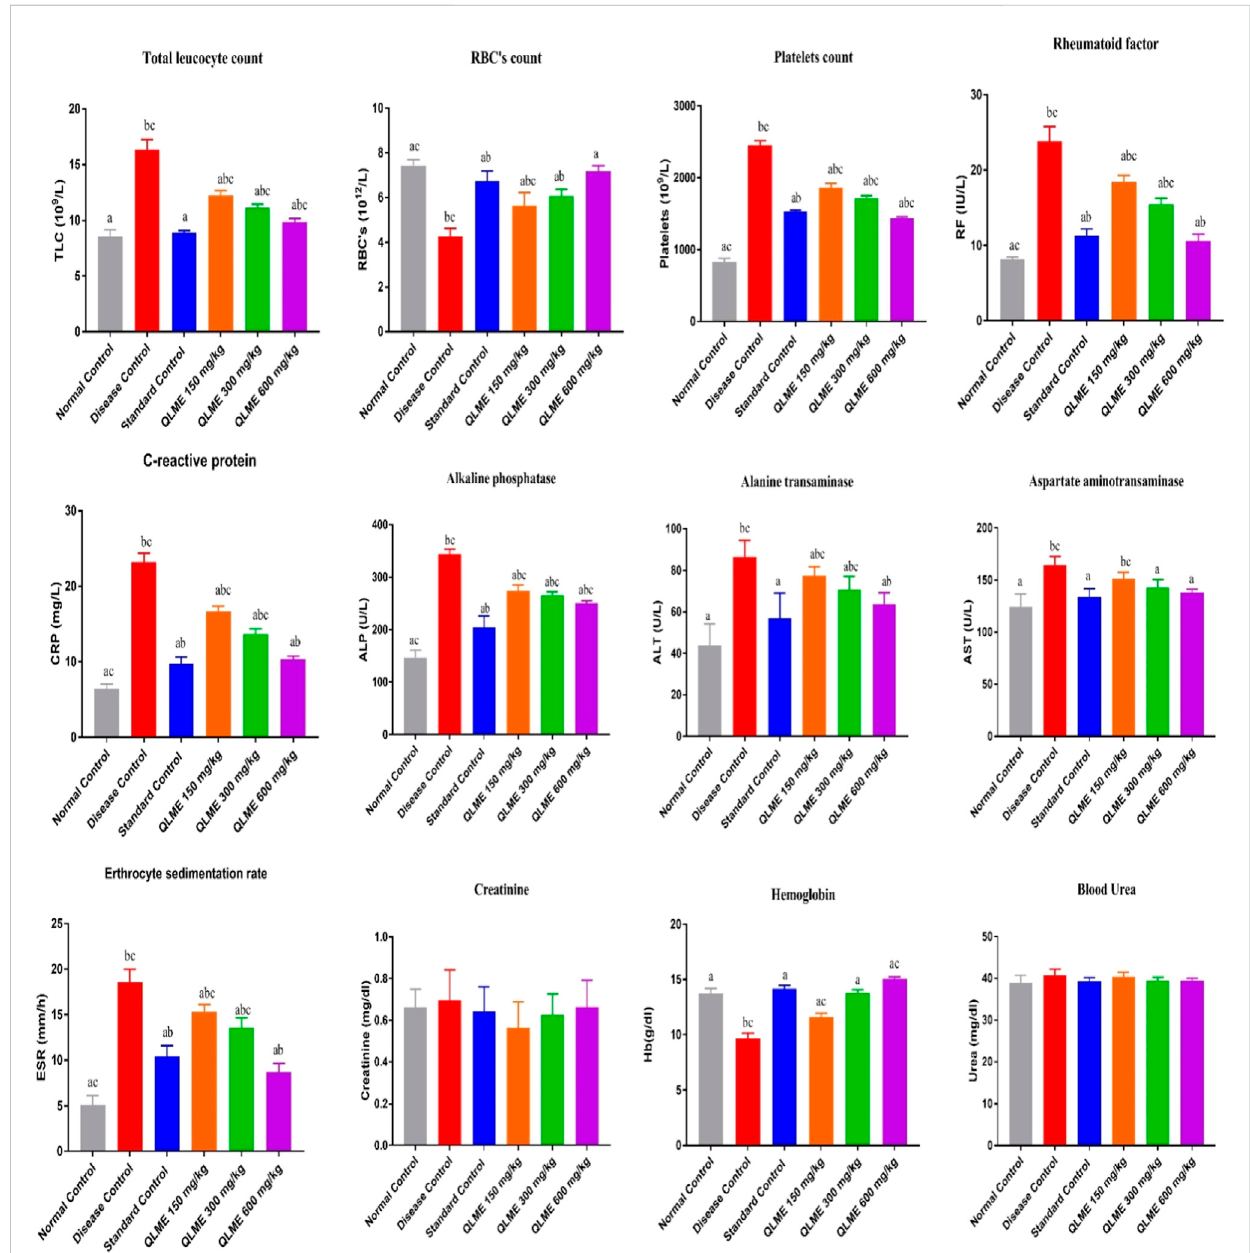
Effects of Quercus leucotrichophora extracts on blood parameters in CFA-induced arthritic rats. Results are expressed as mean ± S.D (n = 6) and one-way ANOVA followed by Tukey ’ s test. a: disease control; b: normal control; and c: standard control. QLME: Quercus leucotricophora methanolic